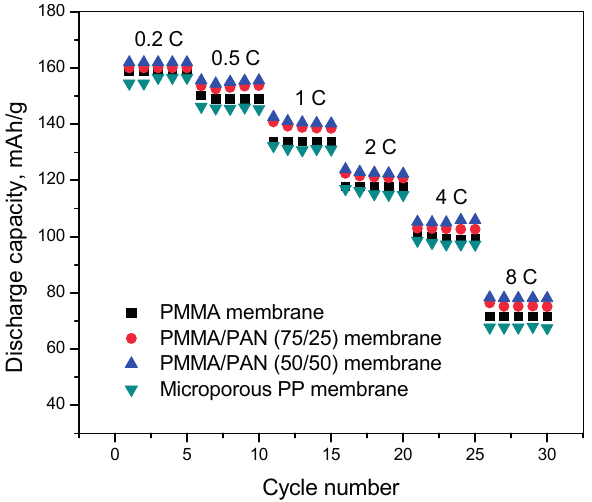
Figure 8. C-rate performance of Li/LiFePO 4 cells containing PMMA membrane, PMMA/PAN (75/25) membrane, PMMA/PAN (50/50) membrane, and microporous PP